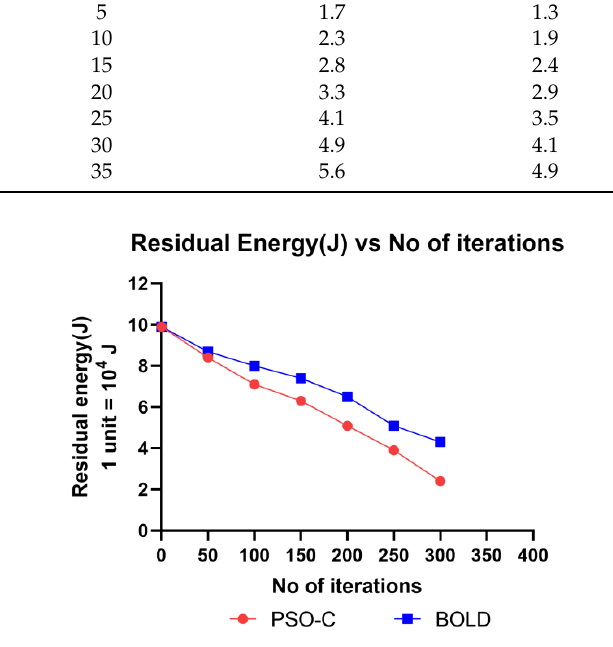
Figure 12. Residual energy vs each iteration.